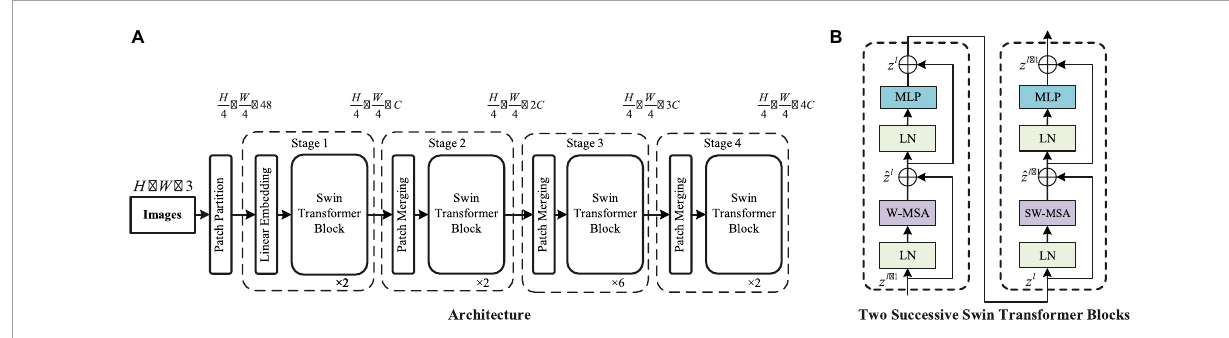
FIGURE2 Architecture of a Swin Transformer: (A) Structure of a Swin Transformer (Swin-T). (B) Two successive Swin Transformer blocks. Window based self-attention (W-MSA) and shifted window based self-attention (SW-MSA) are multihead self-attention modules with regular and shifted windowing configurations, respectively (Vaswani et al.,